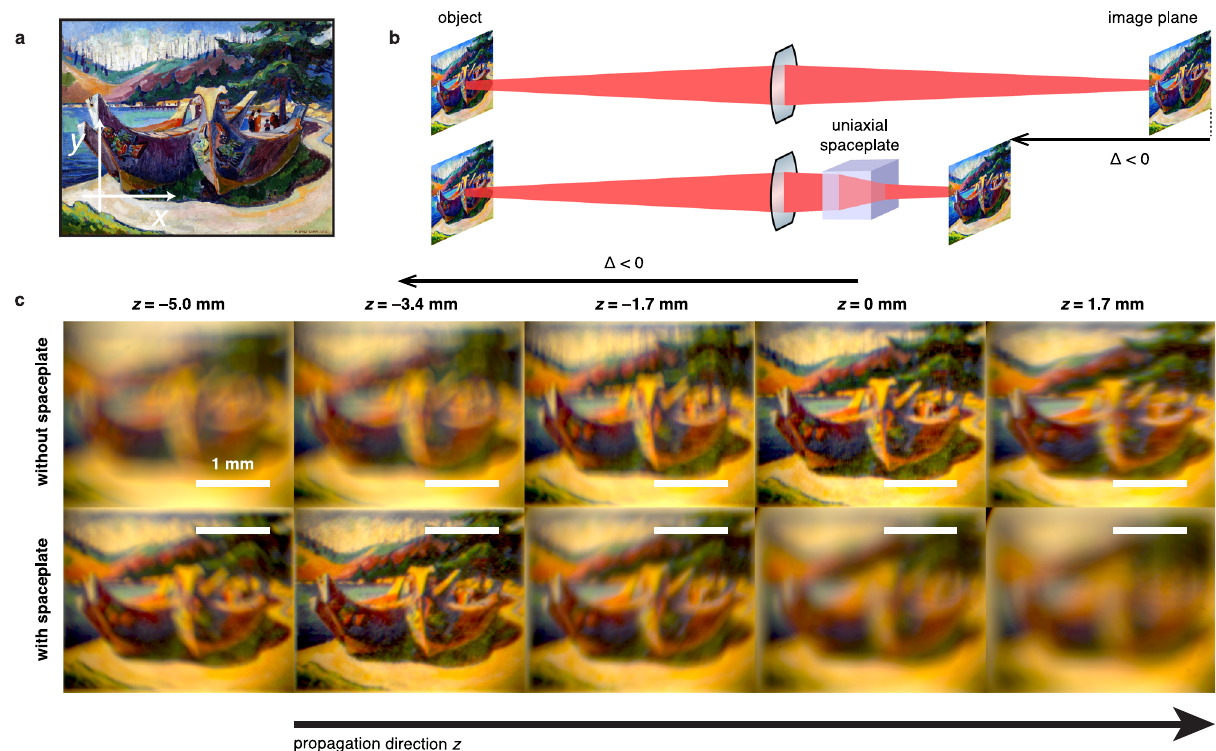
Fig. 4 Advance of a broadband visible image using a spaceplate. a This print of a painting was illuminated with incoherent white light. b An image of the print is formed in either a background medium, glycerol, or through the calcite spaceplate in glycerol. c Camera images at various distances z . The spaceplate advances the focal plane of the image by Δ = − 3.4 mm relative to the glycerol alone. The scale bar is the same length in all the images. This result illustrates that the spaceplate does not change the magni fi cation, i.e., it does not introduce any focusing power. Note that the yellow tint of the recorded images is due to the